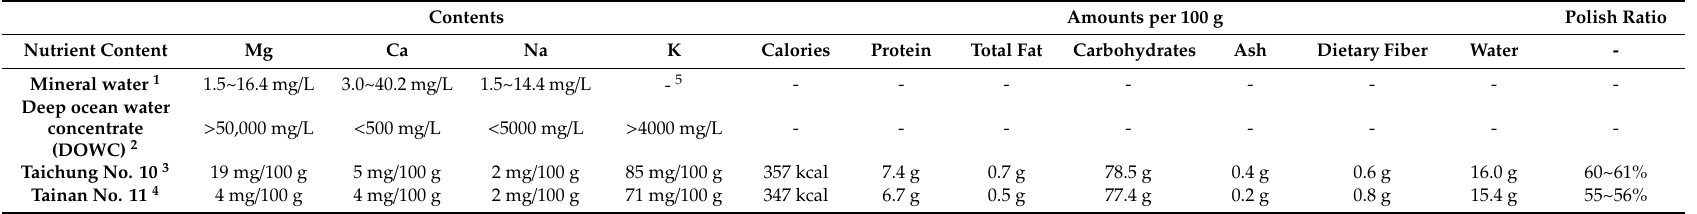
Table 1. Nutrient composition of deep ocean water and rice raw